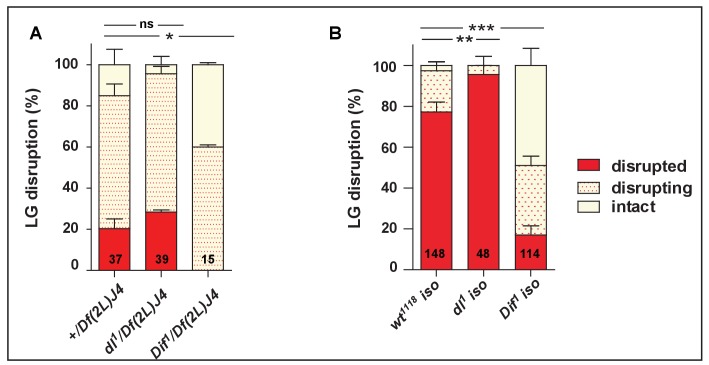
Dif but not Dorsal is required for proper lymph gland disruption in response to wasp parasitism.Quantification (%) of lymph gland disruption in (A): +/Df(2L)J4 (control), dl1/Df(2L)J4 and Dif1/Df(2L)J4 mutant larvae and (B) in the isogenic strains wt1118 (control), dl1 and Dif1. Error bars correspond to SEM, *p<0.1, **p<0.01, ***p<0.001, ns (not significant) (Pearson’s Chi-squared test).10.7554/eLife.25496.004Figure 1—figure supplement 1—source data 1.Lymph gland disruption quantification.